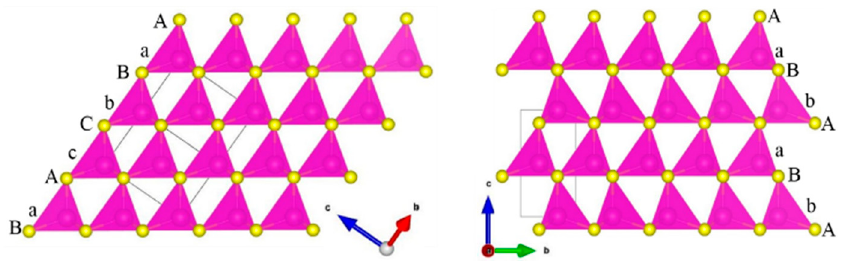
Figure 1. Sketch of ZB ( left ) and WZ ( right ) structures: different stacking of layers of tetrahedrons along the [111] (cubic) and the [001] (hexagonal) axes. Capital and lower case letters designate anion and cation positions respectively.